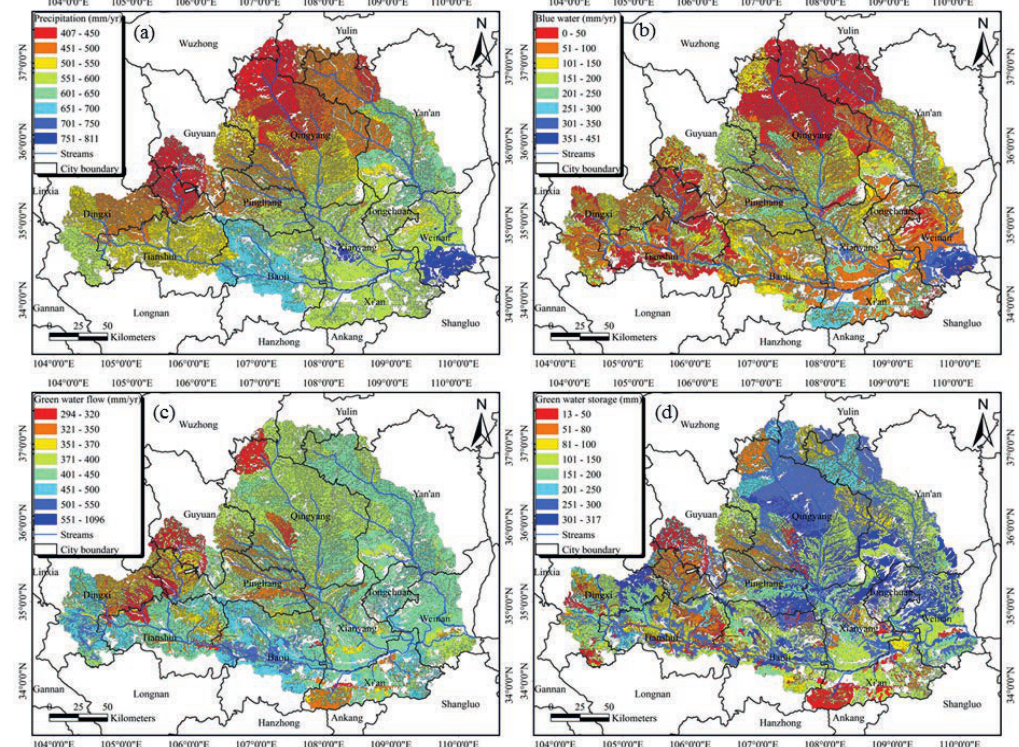
Fig. 3 Spatial distributions of the mean 95PPU ranges of annual precipitation (a), blue water (b), green water flow (c), and green water storage (d) on the HRU scale in the WRB during